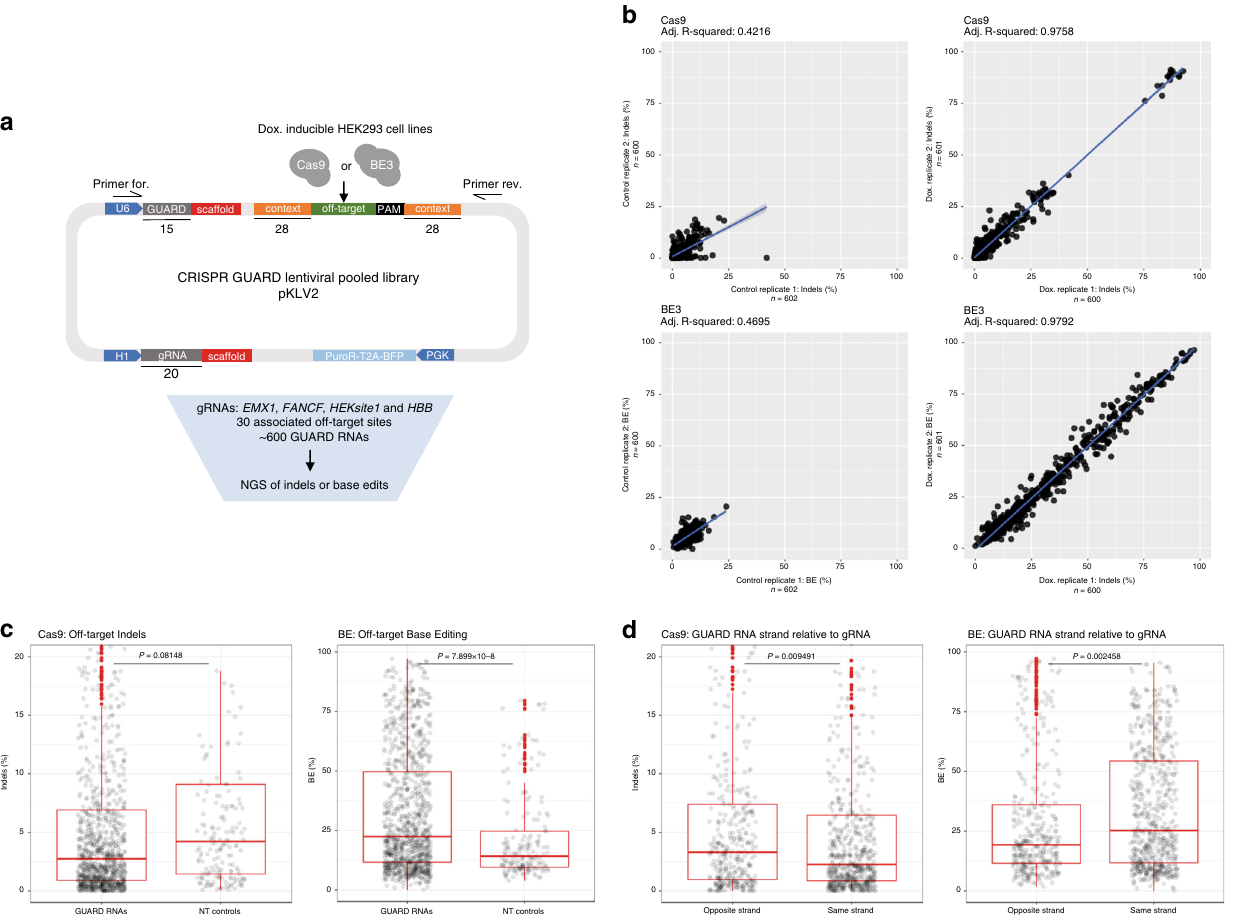
Fig. 5 High-throughput screening identi fi es functional GUARD RNAs. a Schematic of the lentiviral pooled screening approach to analyse off-target editing frequencies in cells expressing different GUARD RNA species. Numbers indicate the length of the plasmid segment in base pairs. b Scatter plots of indels (Cas9) or SNPs (base edits) for two independent replicate experiments with or without induction of Cas9 or BE3 expression with doxycycline for 48 h. c Box and whiskers plot of off-target indel or base editing frequency for coding and non-targeting (NT) GUARD RNAs in the Cas9 or base editor screen, respectively. NB: some outliers fall outside of the y -axis limit. d GUARD RNAs binding to the same DNA strand as the gRNA are more effective at blocking Cas9 off-target editing but can increase base editing ef fi ciency. Box and whiskers plot of off-target indel or SNP frequencies in the screens. NB: some outliers fall outside of the y -axis limit. Box and whiskers plot: centre line, median; box limits, upper and lower quartiles; whiskers, 1.5× interquartile range; points, outliers. Data were compared using unpaired, two-tailed student ’ s t